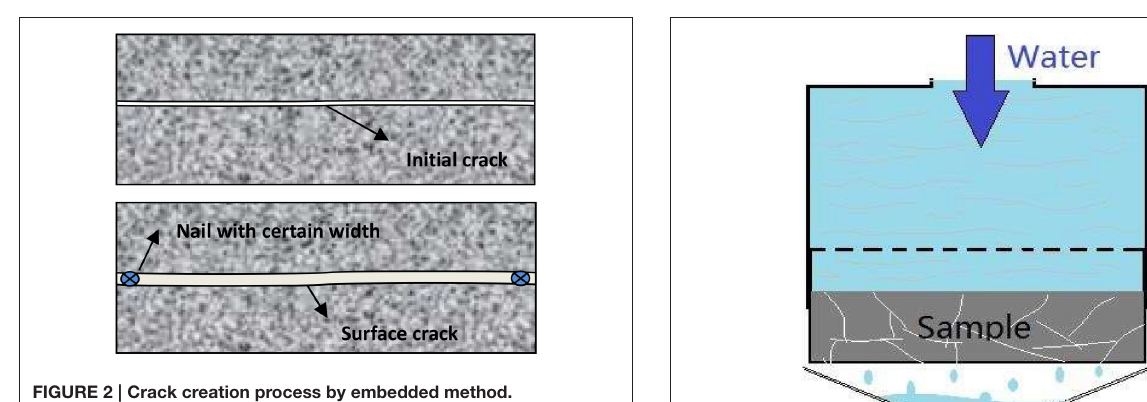
FIGURE 2 | Crack creation process by embedded method.